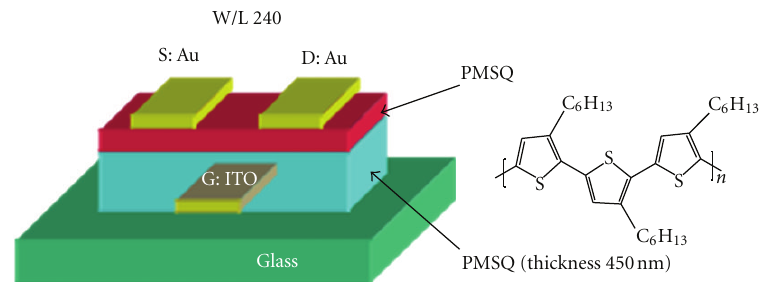
Figure 6: O-TFT (bottom-gate/top-contact type) with PMSQ and P3HT.